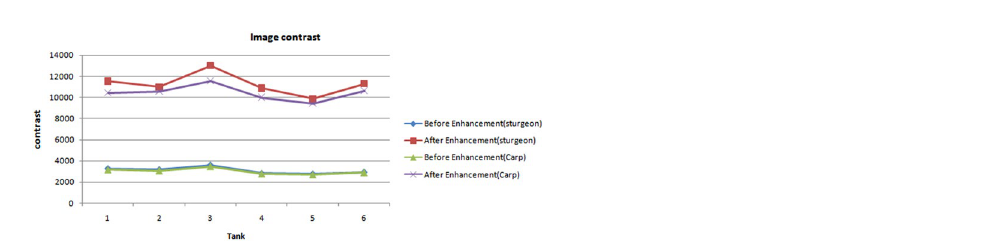
Figure 7. Image enhancement results of carp: ( a ) original image of carp; ( b ) enhancement results; ( c ) histogram of Fig. 7a;( d ) histogram of Fig. 7b.